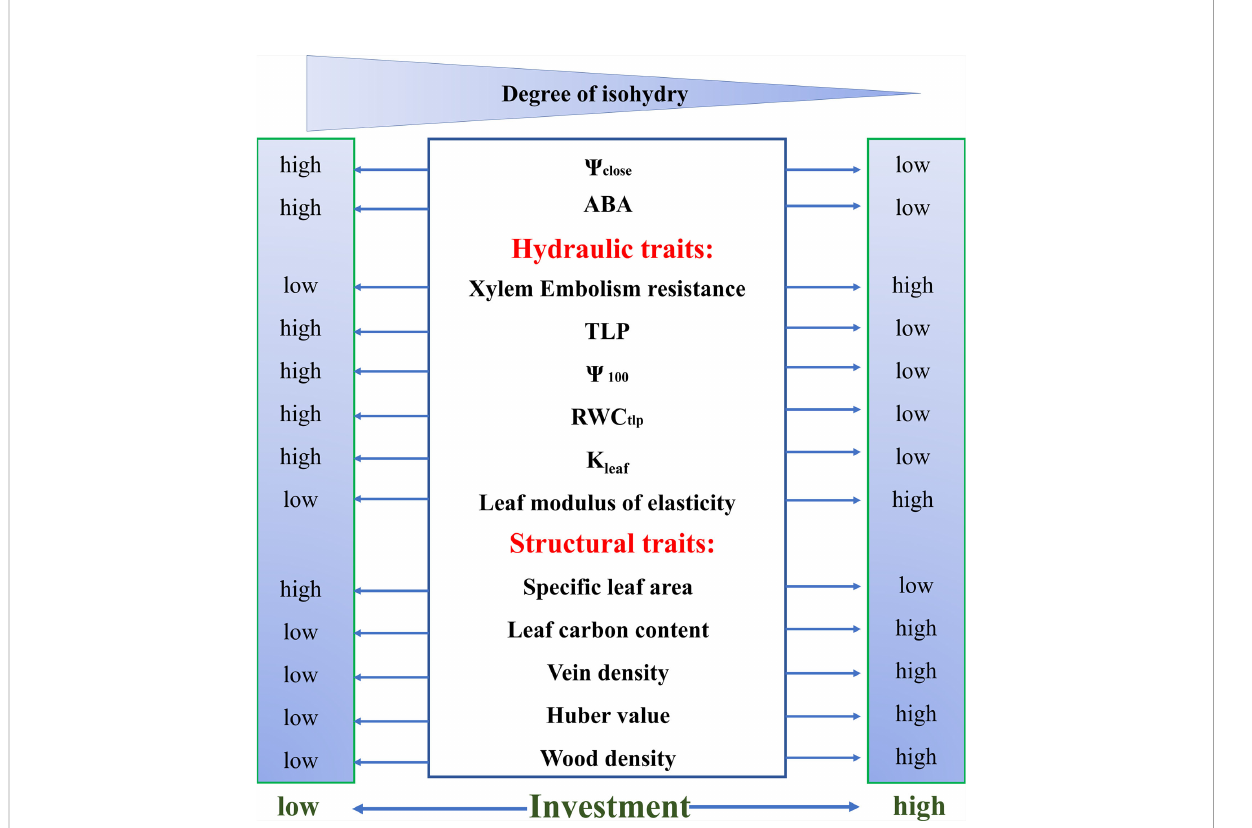
FIGURE 2 The relationships between the iso/anisohydric behavior and functional traits of leaves and branches, which show how these traits vary with the Y close . The anisohydric species show stronger stress resistance, with greater investment in stems and leaves than the isohydric species to maintain stomatal opening under drought conditions. Y close (water potential at stomatal closure), TLP (turgor loss point), Y 100 (osmotic potential at full turgor), RWC tlp (relative water content at TLP), K leaf (leaf hydraulic conductance). This fi gure is changed from Chen et al.